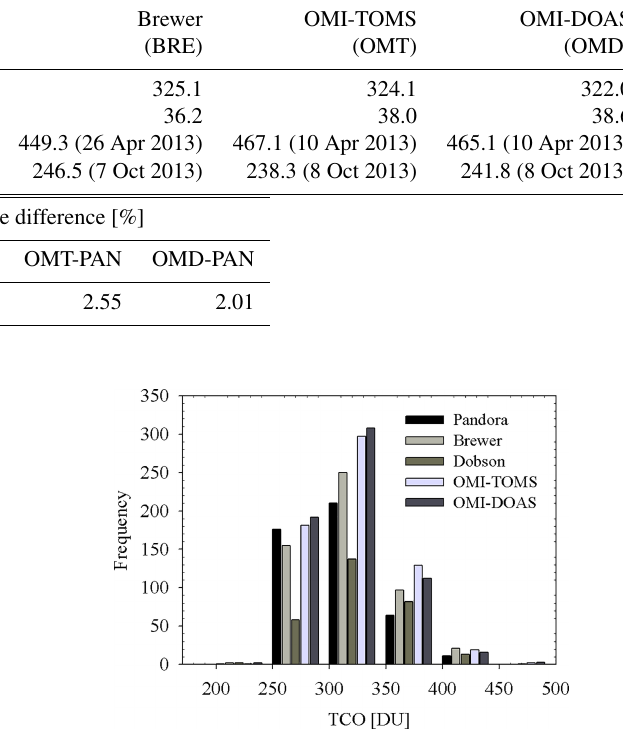
Figure 3. Histogram of daily TCO values from the four instruments (Pandora, Brewer, Dobson, and OMI (TOMS and DOAS)). Vertical axis (frequency) stands for the number of data in each TCO